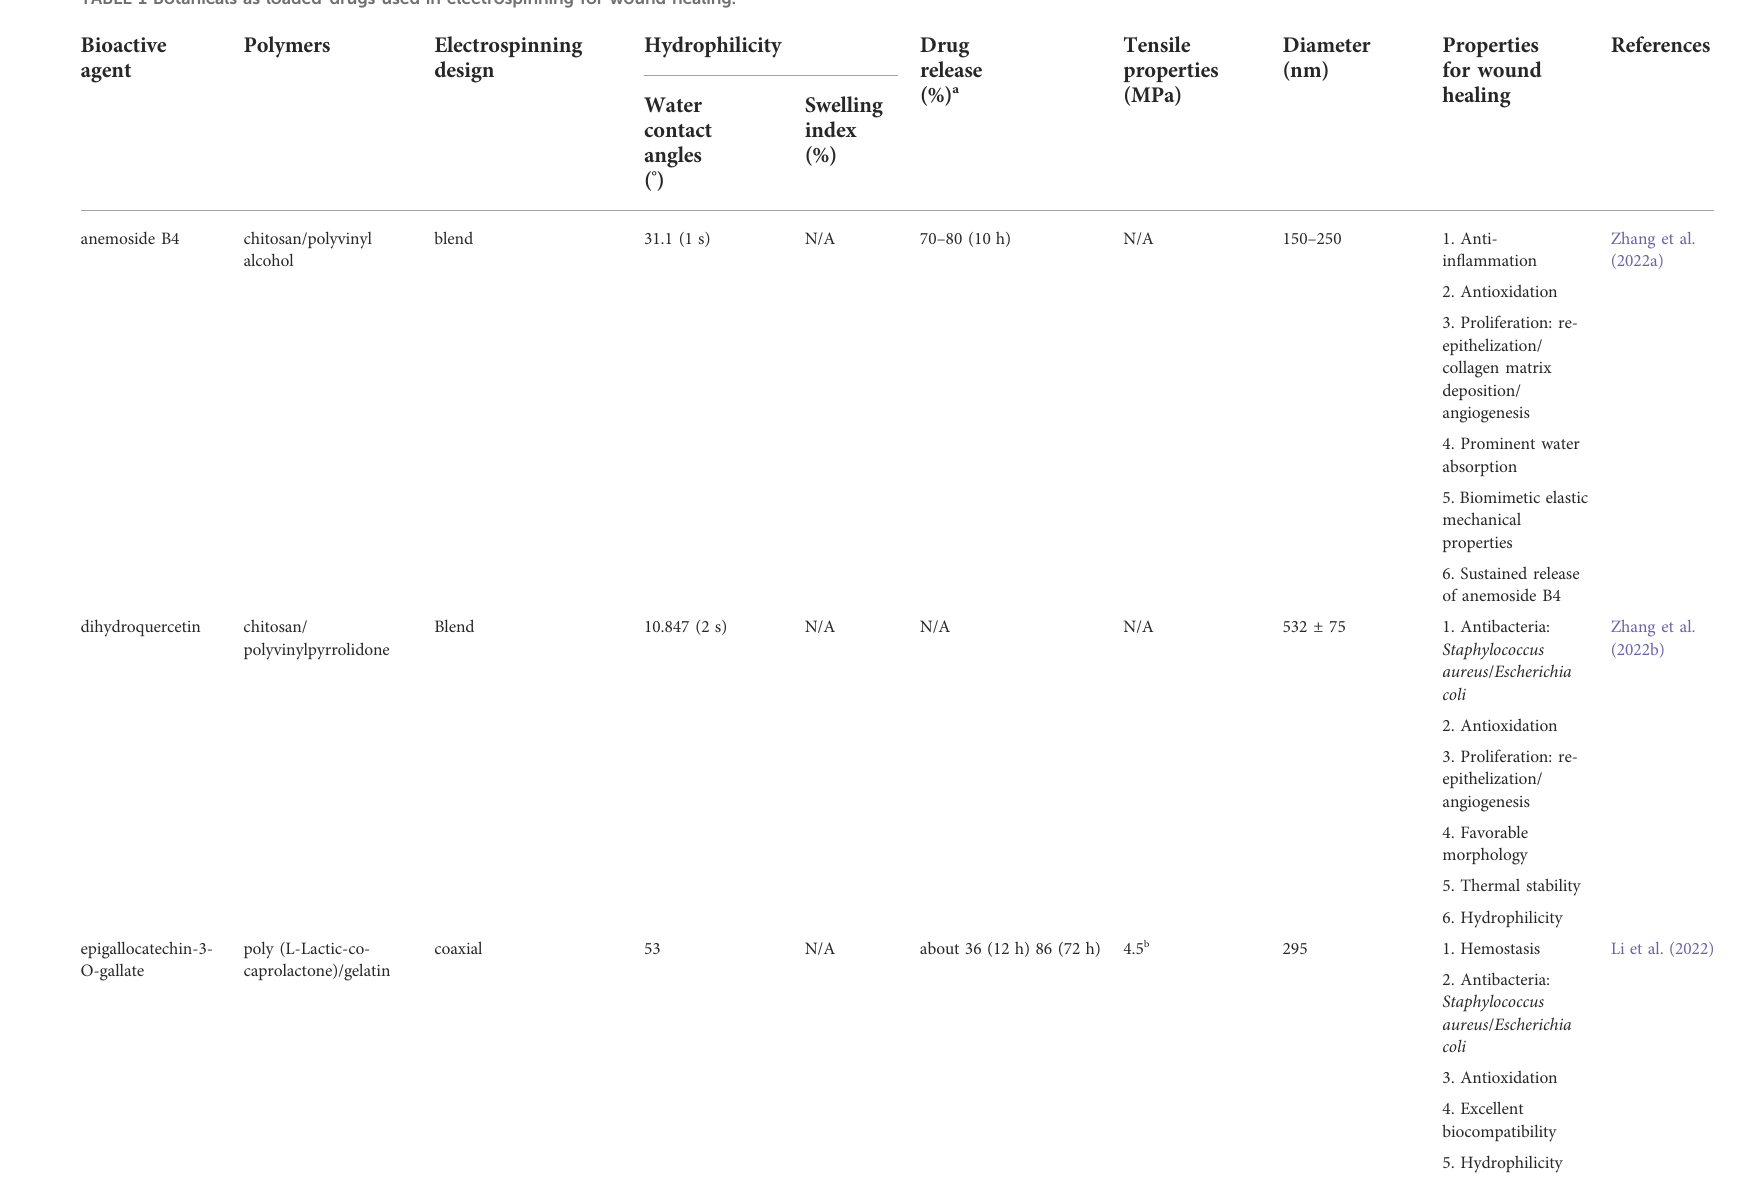
TABLE 1 Botanicals as loaded-drugs used in electrospinning for wound